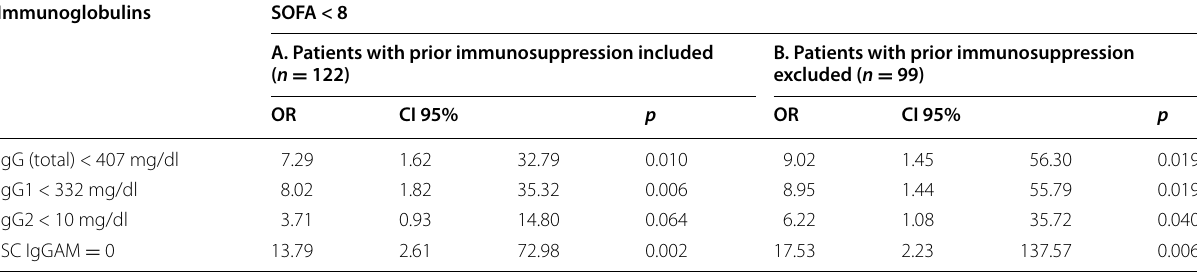
Adjusting variables for A. were (diabetes mellitus) (presence of prior immunosuppression) (APACHE‑II score) (presence of respiratory infection), (microbiologically confirmed infection). Adjusting variables for B. were (APACHE‑II score) (presence of respiratory infection), (presence of abdominal infection) (microbiologically confirmed